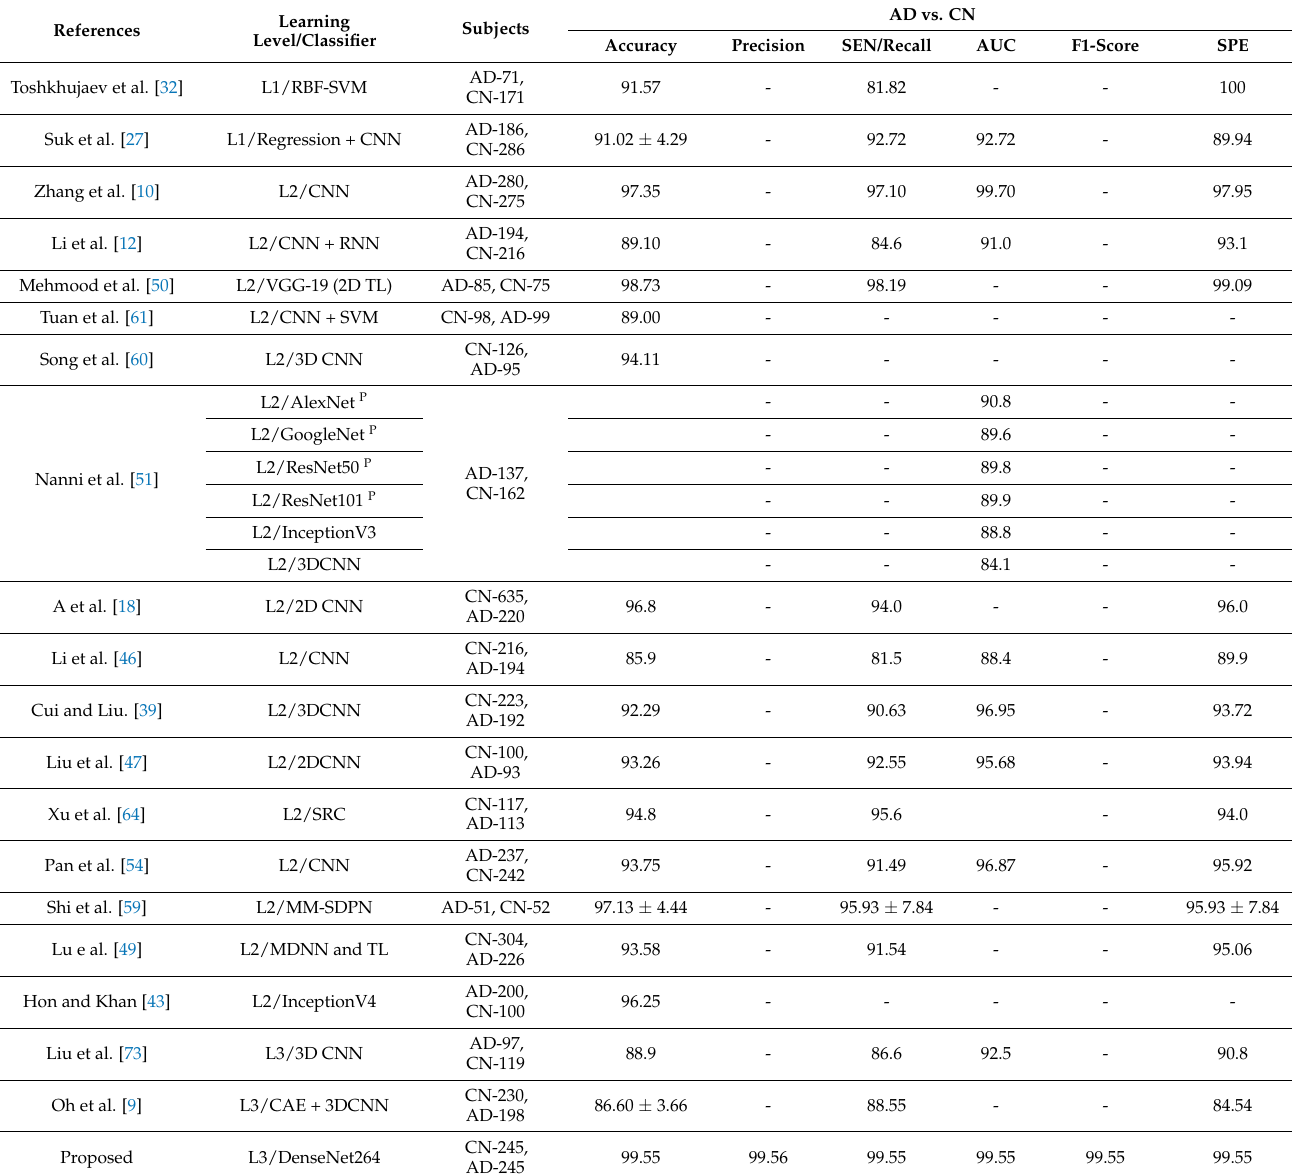
Table 14. Classification (AD vs. CN) performance of the published state-of-the-art